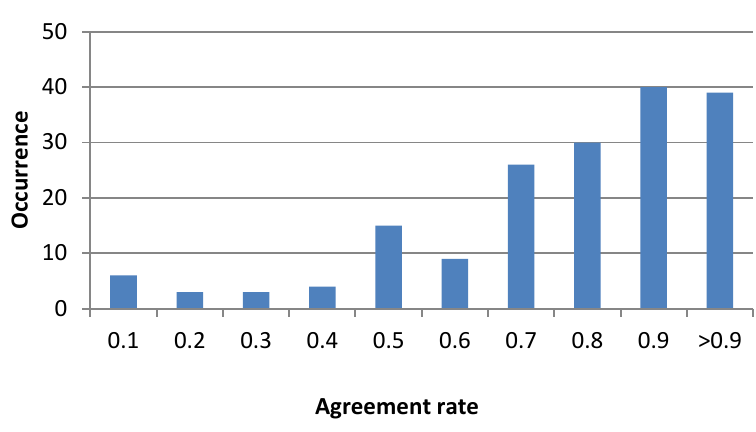
Figure 14. Frequency of agreement rate across all individual observations in the study data base irrespective of date. The distribution favors high agreement rates on-the-whole. Poorly performing sites tend to be